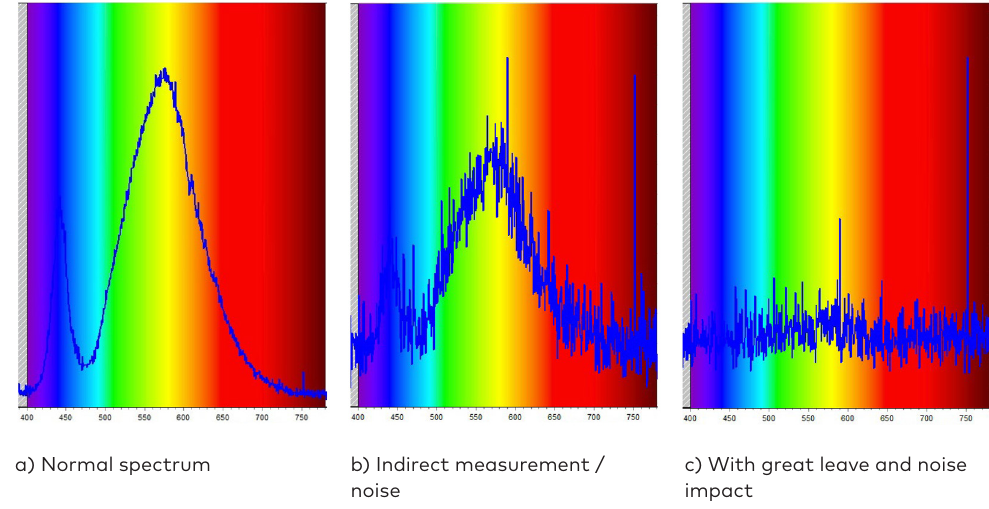
Figure 14. Typical samples of spectrum